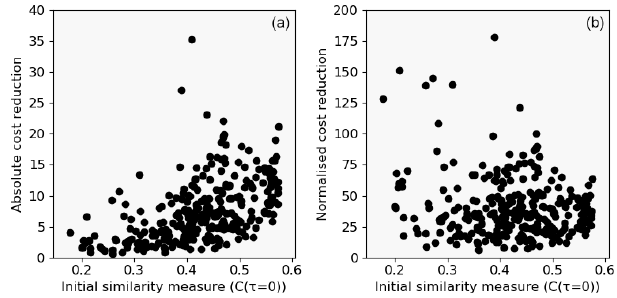
Figure 6. Absolute (a) and normalised (b) cost reduction of healthy signals by imposing one CP versus average